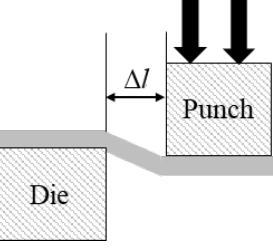
Figure 2. Illustration of the punch-and-die method for the shear property measurement of a GDL.